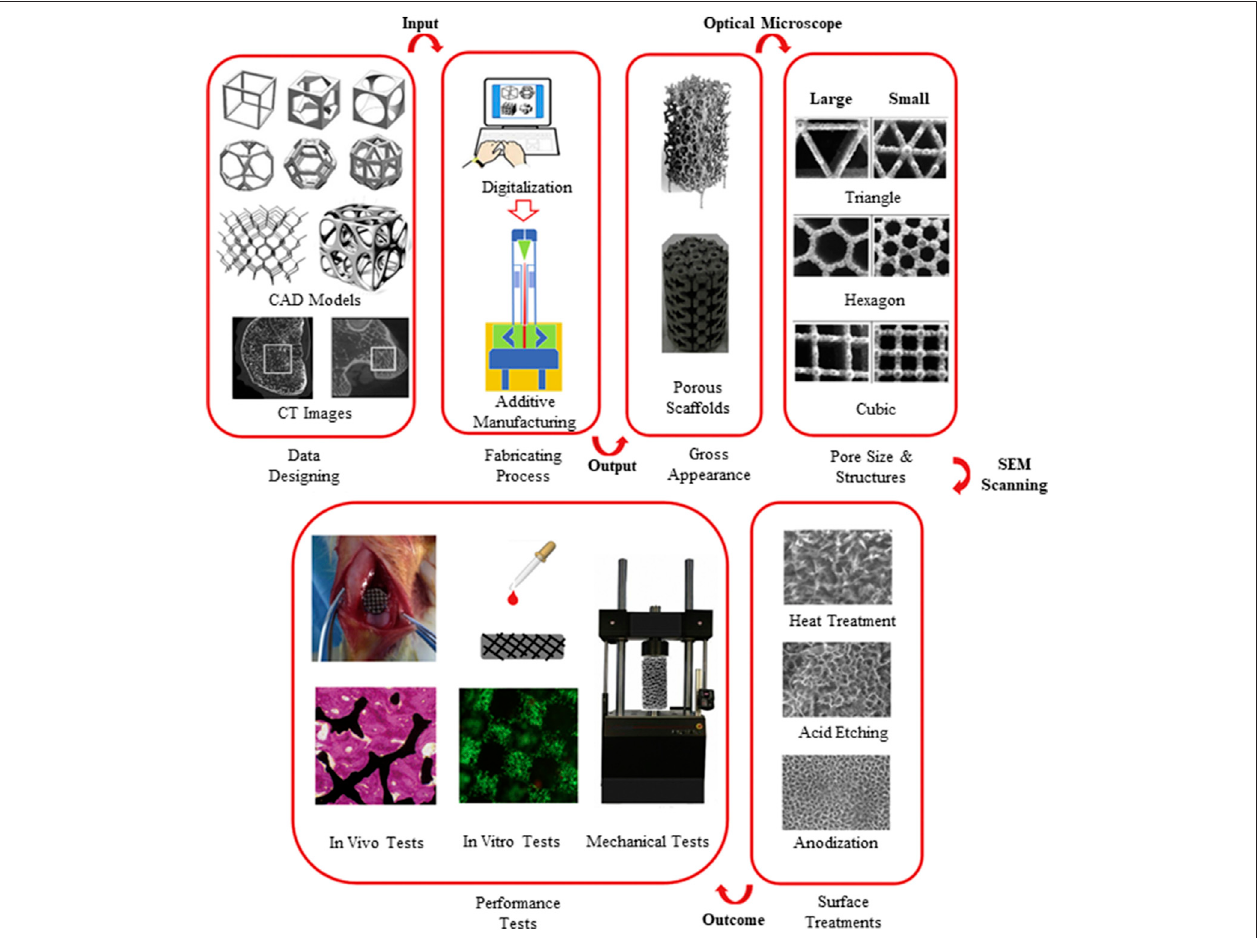
FIGURE 2 | A step-by-step approach of design control and performance evaluation to achieve successful fabrication of a 3D-printed biomedical implant (Wang et al., 2017).